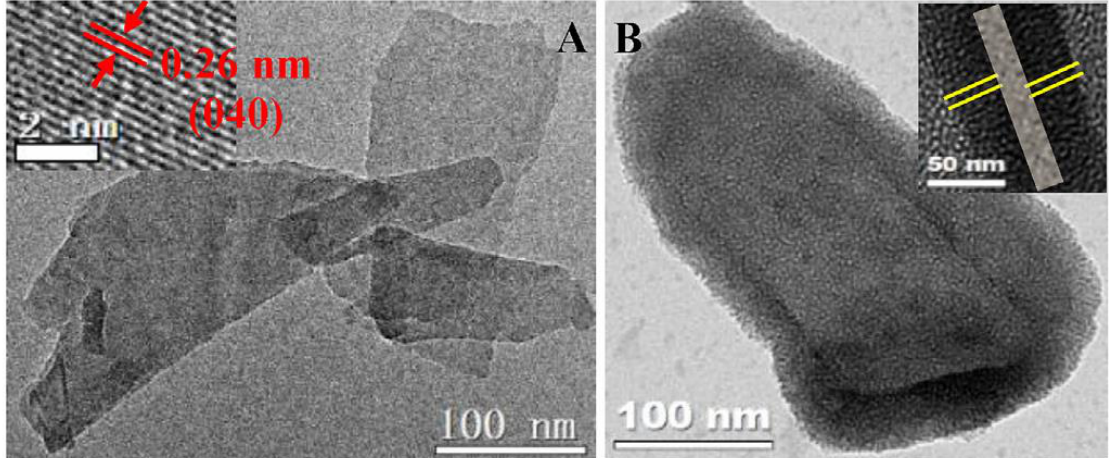
Figure 5. TEM image of ( A ) pristine BP nanosheet, and ( B ) BP@MS (Mesoporous silica). Reproduced with permission from [81]; Copyright Elsevier, 2020.